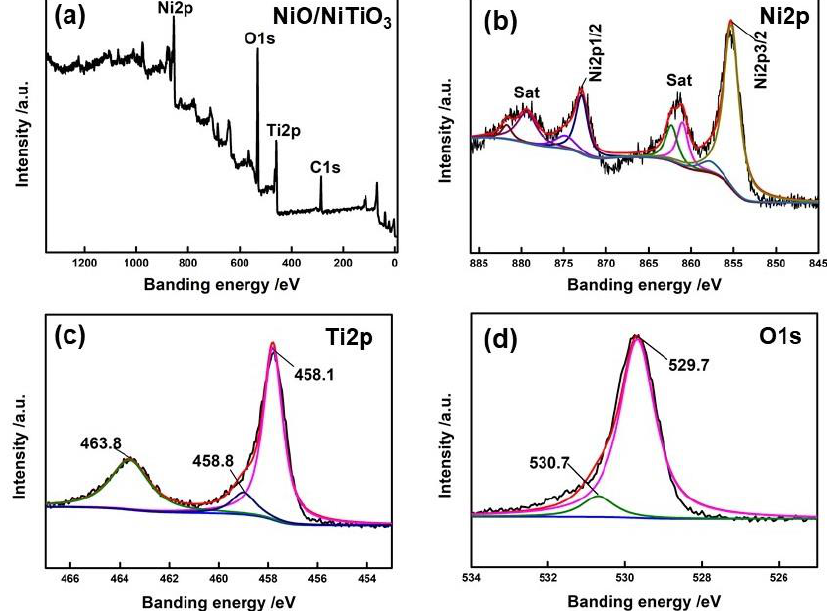
Figure 2. XPS spectra of NiO/NiTiO 3 composite nanofibers calcined at 800 C°. ( a ) survey scan, and high-resolution scans of ( b ) Ni2p, ( c ) Ti2p, and ( d ) O1s. high-resolution scans of ( b ) Ni2p, ( c ) Ti2p, and ( d )